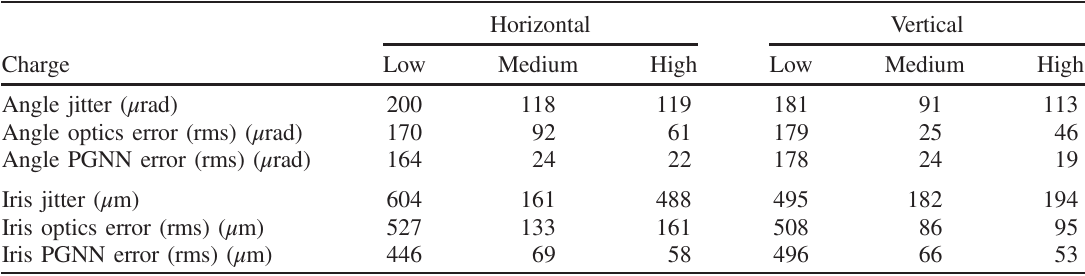
TABLE V. Angle jitter and position jitter propagated to the iris, both calculated using measurements at the last two BPMs. Comparison with the rms errors from the optics model predictions and PGNN model